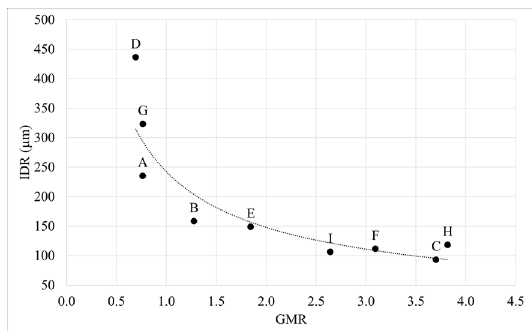
Figure 8. IDR as a function of GMR.